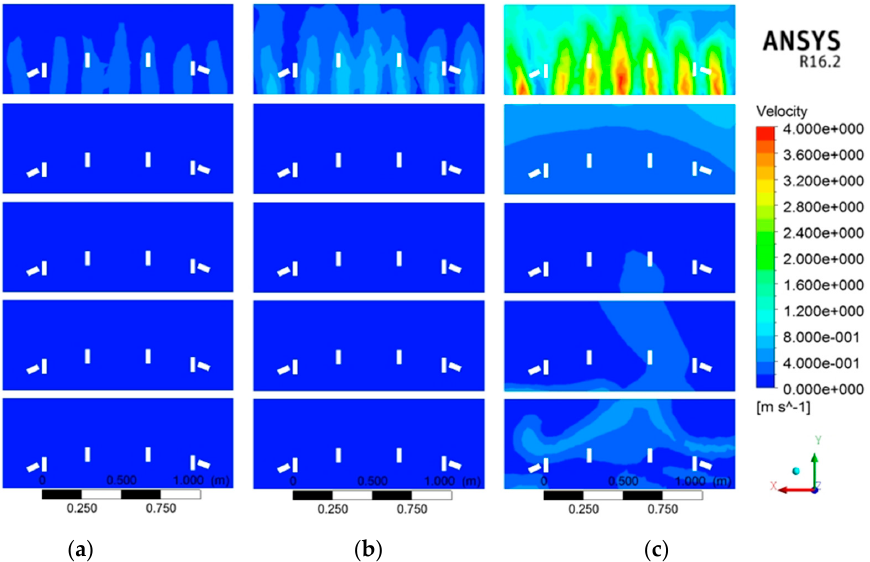
Figure 13. Computed velocity maps at frontal face areas of virtual boxes. Original system operating at inlet oil velocity of ( a ) 0.5 m/s, ( b ) 1 m/s and ( c ) 5 m/s.